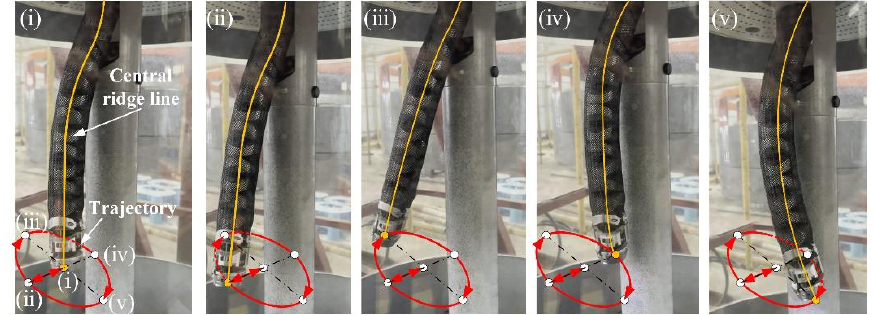
Machines 2022 , 10 , x FOR PEER REVIEW 16 of 20 Figure 12. Circular-trajectory motion of the suction ball. ( ⅰ – ⅴ ) Points of the selected circular trajec- Figure 12. Circular-trajectory motion of the suction ball. (i–v) Points of the selected circular trajectory. Figure 12. Circular-trajectory motion of the suction ball. ( ⅰ – ⅴ ) Points of the selected circular trajec- tory tory